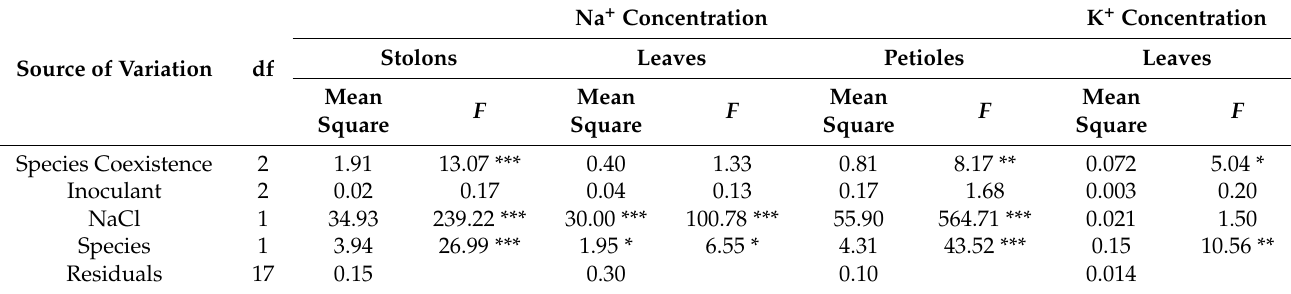
Table 12. ANOVA analysis of tissue Na + and K +